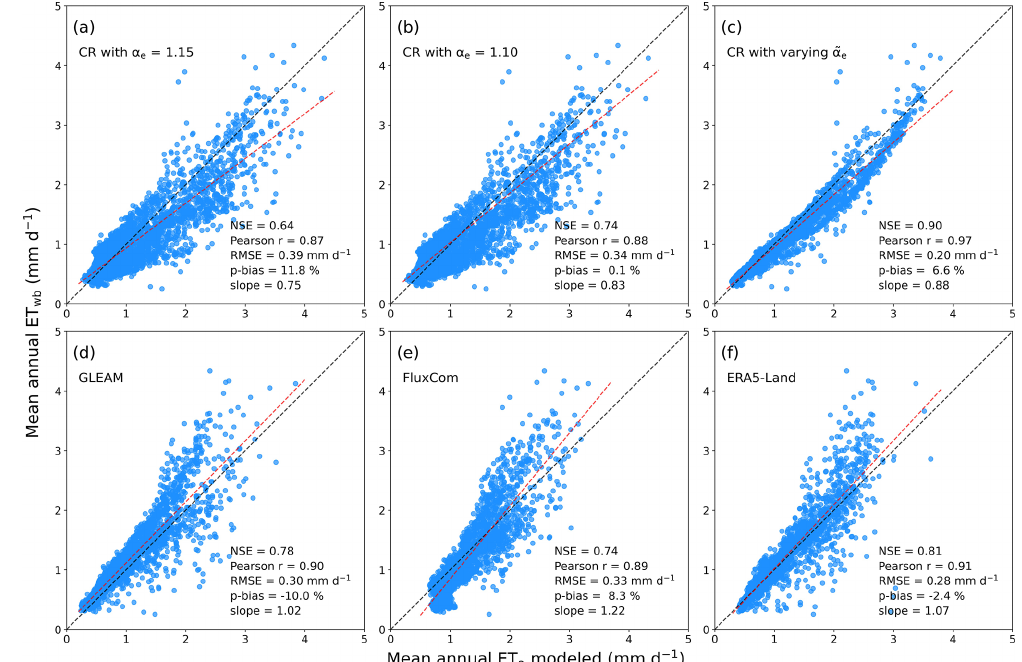
Figure 8. Scatter plots between the mean annual ET wb for 1998–2014 at 0 . 5 ◦ × 0 . 5 ◦ and the predictions by (a) CR with α e = 1 . 15, (b) CR with α e = 1 . 10, (c) CR with spatially varying ˜ α e , (d) GLEAM, (e) FluxCom, and (f) ERA5-Land.